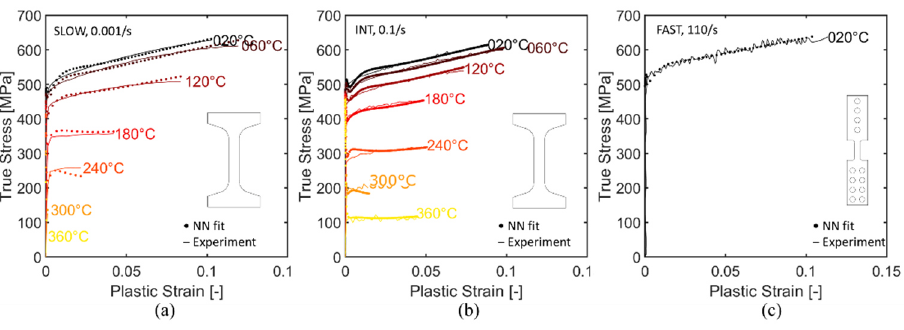
Fig. 4. Neural Network based hardening function (dots) plotted against the experimental curves (solid lines). Note the model’s high flexibility in dealing with curves with significant strain hardening at lower temperatures and moderate strain hardening at higher